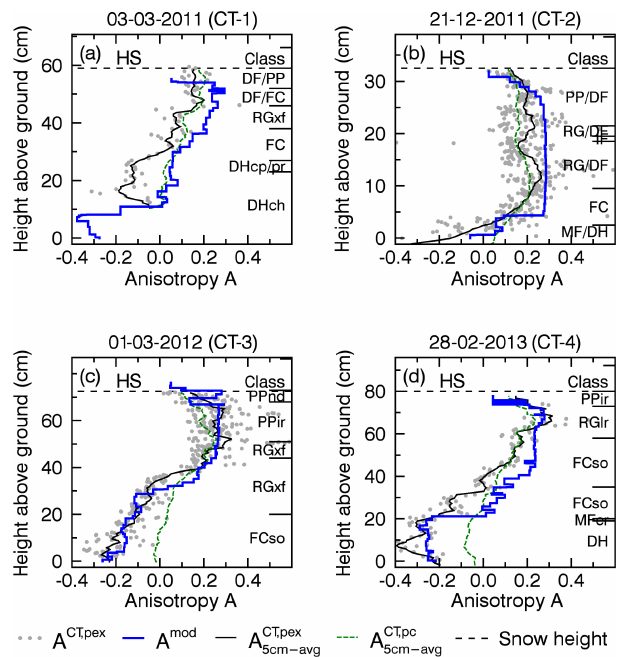
Figure 8. Comparison of simulated anisotropy ( A mod , blue line), with field-measured CT anisotropy profiles ( A CT ,p ex , gray dots; black line: 5cm running mean). Right axis: snow layer classifica- tion according to Fierz et al. (2009) and measured snow height (HS, horizontal black dashed line). The anisotropy determined from the correlation length p c is shown as a green line (5cm running mean). The locations where the CT profiles were taken are shown in Fig.